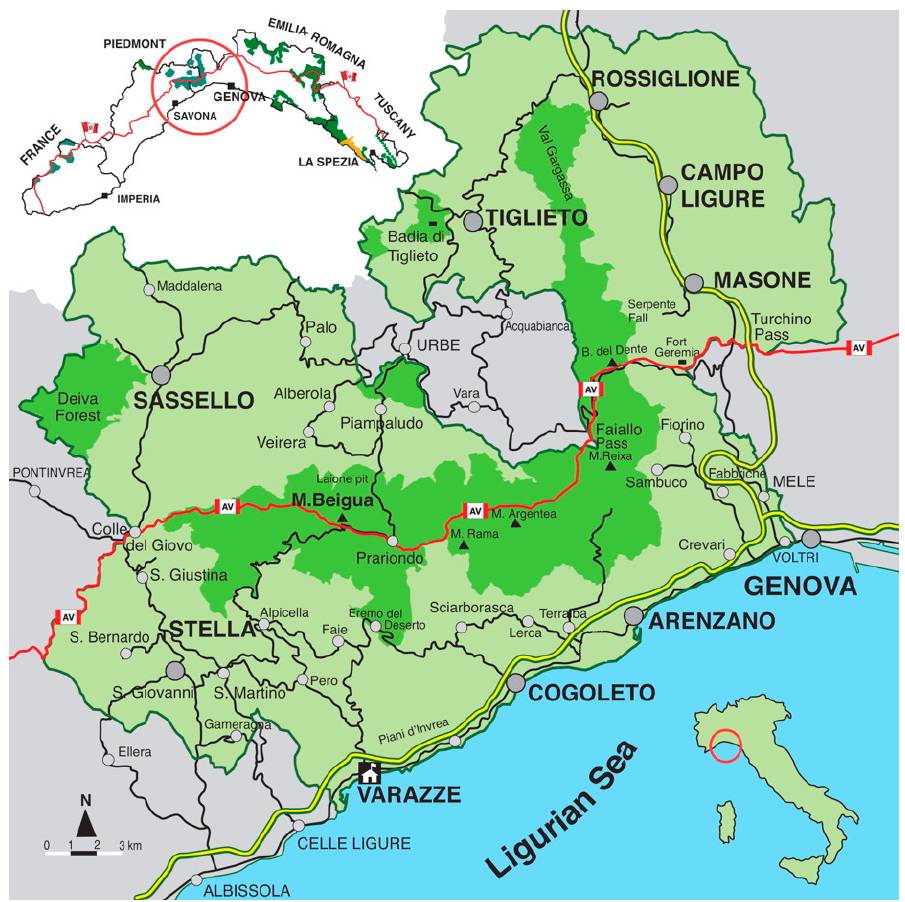
Figure 1. Geographic location of Beigua Geopark territory. Dark green: Beigua Regional Nature Park; Light green: Beigua UGGp. The red line is the “Alta Via dei Monti Liguri” which roughly coincides with the Tyrrhenian–Padanian watershed. In the upper-left inset, the green areas are the Regional Parks of Liguria and the yellow area is the Cinque Terre National Park. Adapted with permission from Ref. [1].